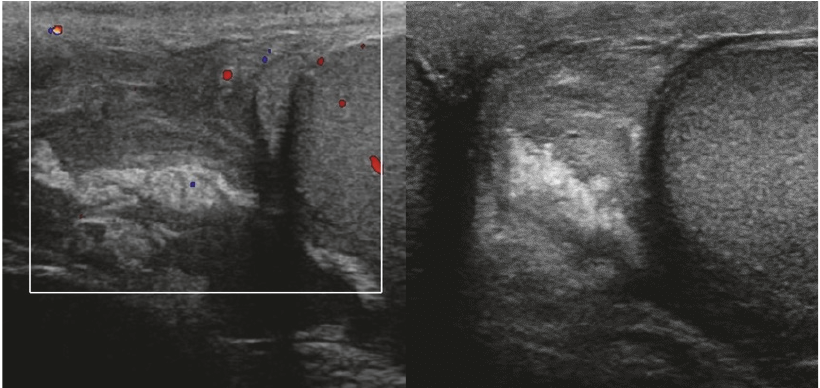
Figure 4: Doppler ultrasonography: a complex collection with internal echoes which is avascular on color Doppler, compatible with hematoma of the spermatic cord.